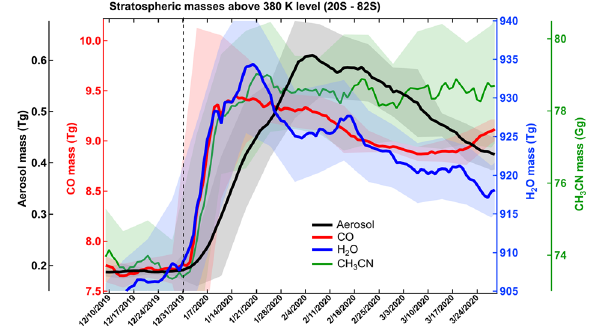
Fig. 4 Time evolution of the daily total mass of CO, CH 3 CN, H 2 O and aerosols above the 380K potential temperature, between 20°S and 82°S. The dotted and solid lines correspond to daily data and 1-week smoothed